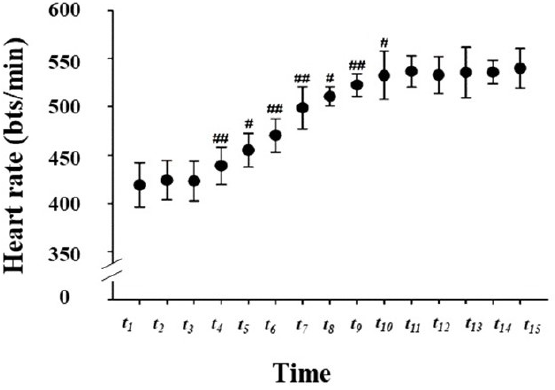
Figure 2 - Changes in mean rat heart rate during exercise